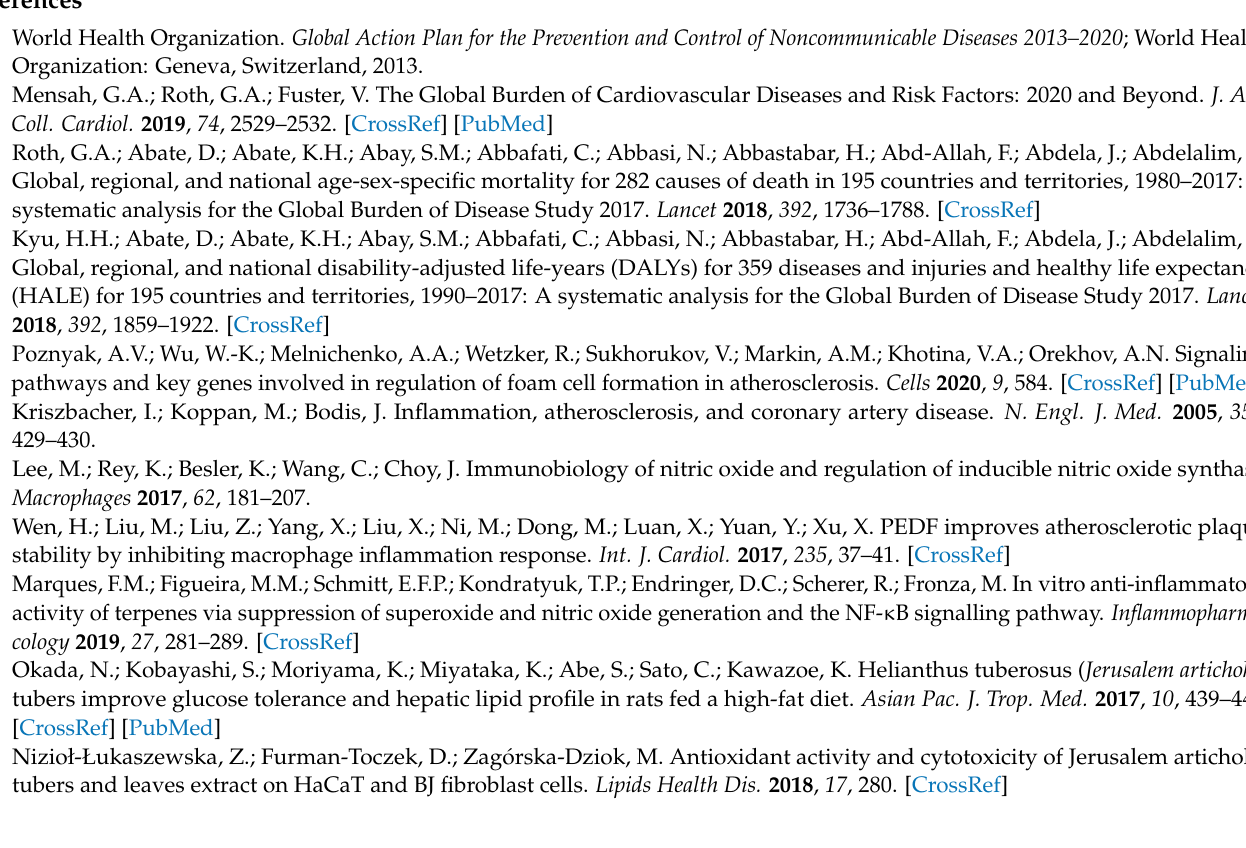
Figure S3. Effects of fractions separated by HPLC in RAW 264.7 cells stimulated with LPS; Figure S4. The one-dimensional (a) 1 H- and (b) 13 C-NMR and (c) two-dimensional COSY spectra of heliangin; Figure S5. Effect of heliangin on VEC viability; Figure S6. Inhibition of TNF- α in VECs; Figure S7. Effects of TNF- α on activation of inflammatory signaling pathways in